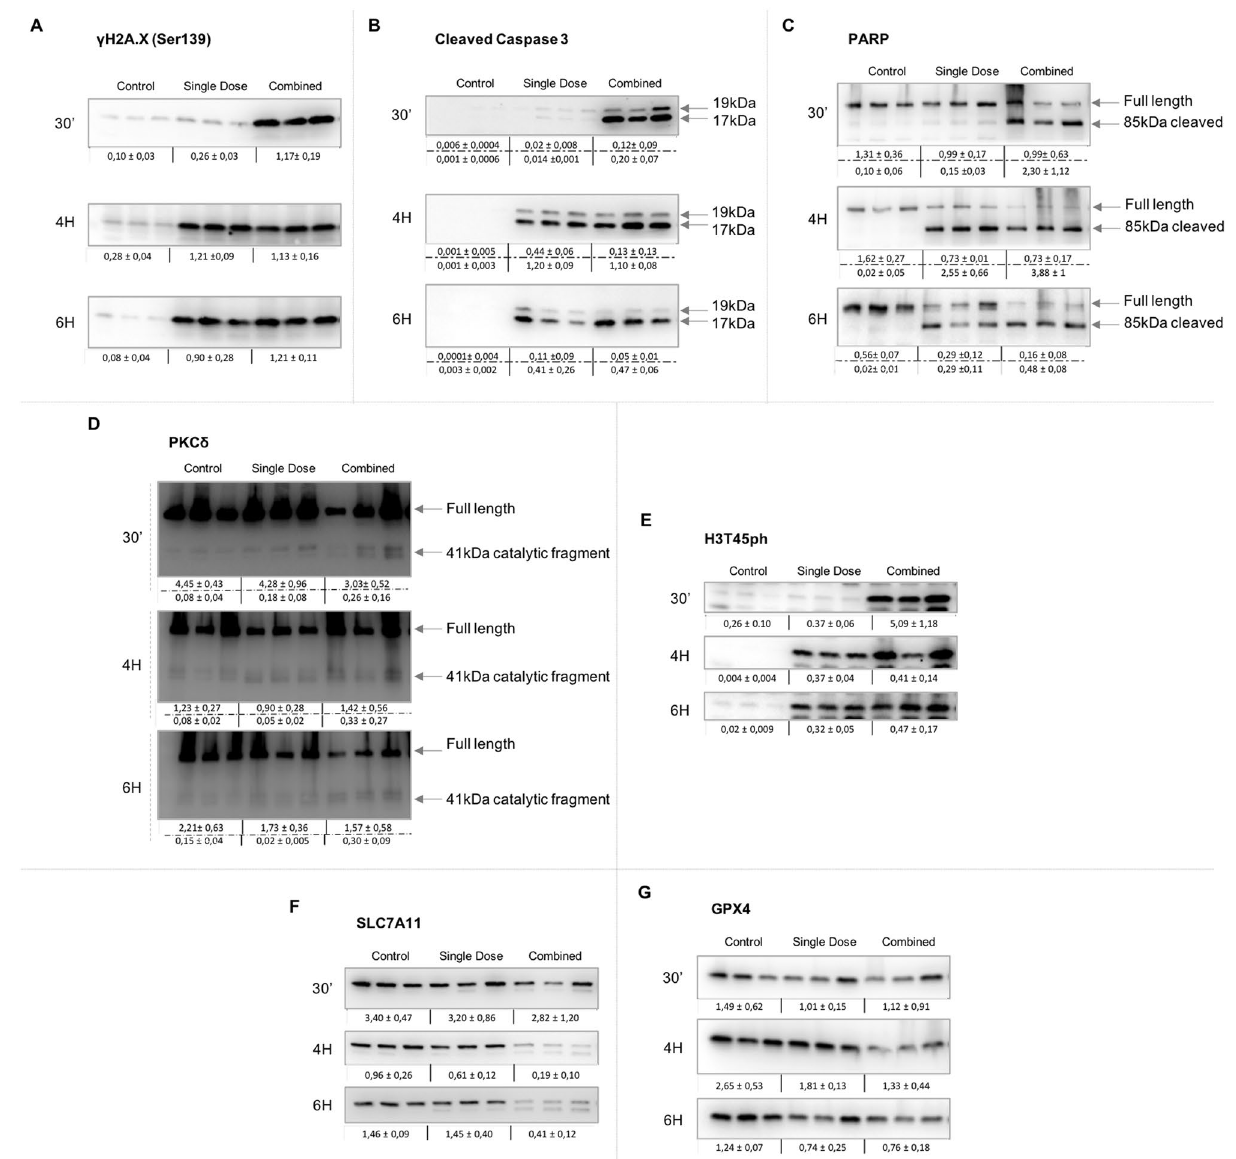
Figure 2. Study of the DNA damage response and cell death pathways in thymocytes in vivo after a single or combined radiation scheme. Time and dose dependent accumulation of DNA damage and apoptotic pathways markers as determined 30 min, 4 and 6 h after irradiation in control and irradiated thymocytes (with single and combine schemes) by immunoblotting. Damage response marker: ( A ) γH2AX-Ser139 (15 kDa). Apoptosis response markers: ( B ) Caspase 3 activated subunits (19 and 17 kDa). ( C ) Poly (ADP-ribose) polymerase-1 (PARP1) full length (116 kDa) and its cleavaged form (89 kDa fragment). ( D ) PKCδ full length (78 kDa) and its catalytic fragment (41 kDa). ( E ) Phosphorylation of H3T45 (H3T45ph) (15 kDa). Ferroptosis response markers: ( F ) xCT (55 kDa) and ( G ) GPX4 (17 kDa). β-Actin was probed as a loading control for each membrane in annexed Fig. 2. Original blots are presented in supplementary